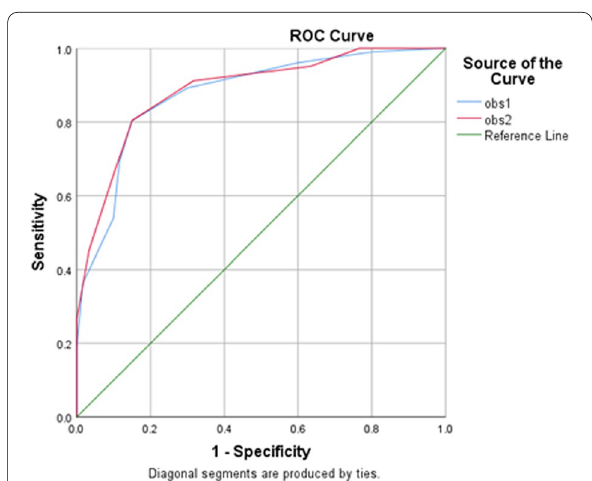
Fig. 2 ROC curve analyses of both observers for the diagnostic performance of the scoring system for metastatic cervical LN detection